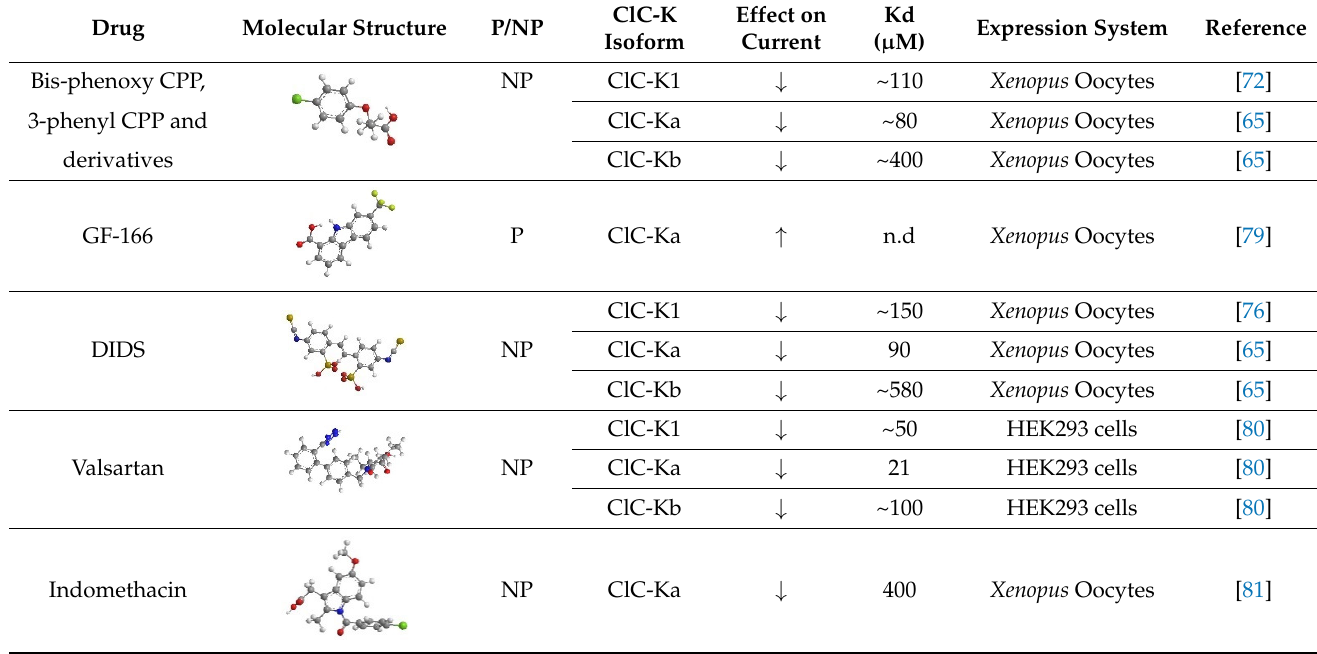
Table 2. Drug effects on ClC-K channels. Table 2. Drug e ff ects on ClC-K channels. Table 2. Drug e ff ects on ClC-K channels. Table 2. Drug e ff ects on ClC-K channels. Table 2. Drug e ff ects on ClC-K channels. Table 2. Drug e ff ects on ClC-K